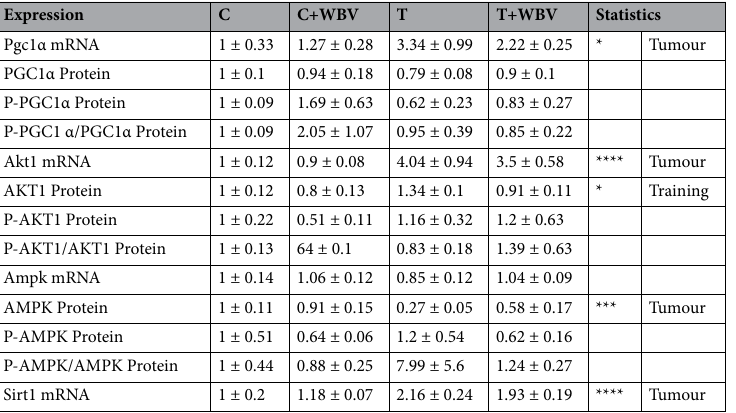
Table 1. Relative gene and protein expression in m. gastrocnemius (mean ± SEM). Two-way ANOVA with factors Tumour, Training and Tumour–Training interaction and Bonferroni Post-Hoc analysis. Significant effects are represented with * p < 0.05 , ** p < 0.01 , *** p < 0.005 , and **** p < 0.001